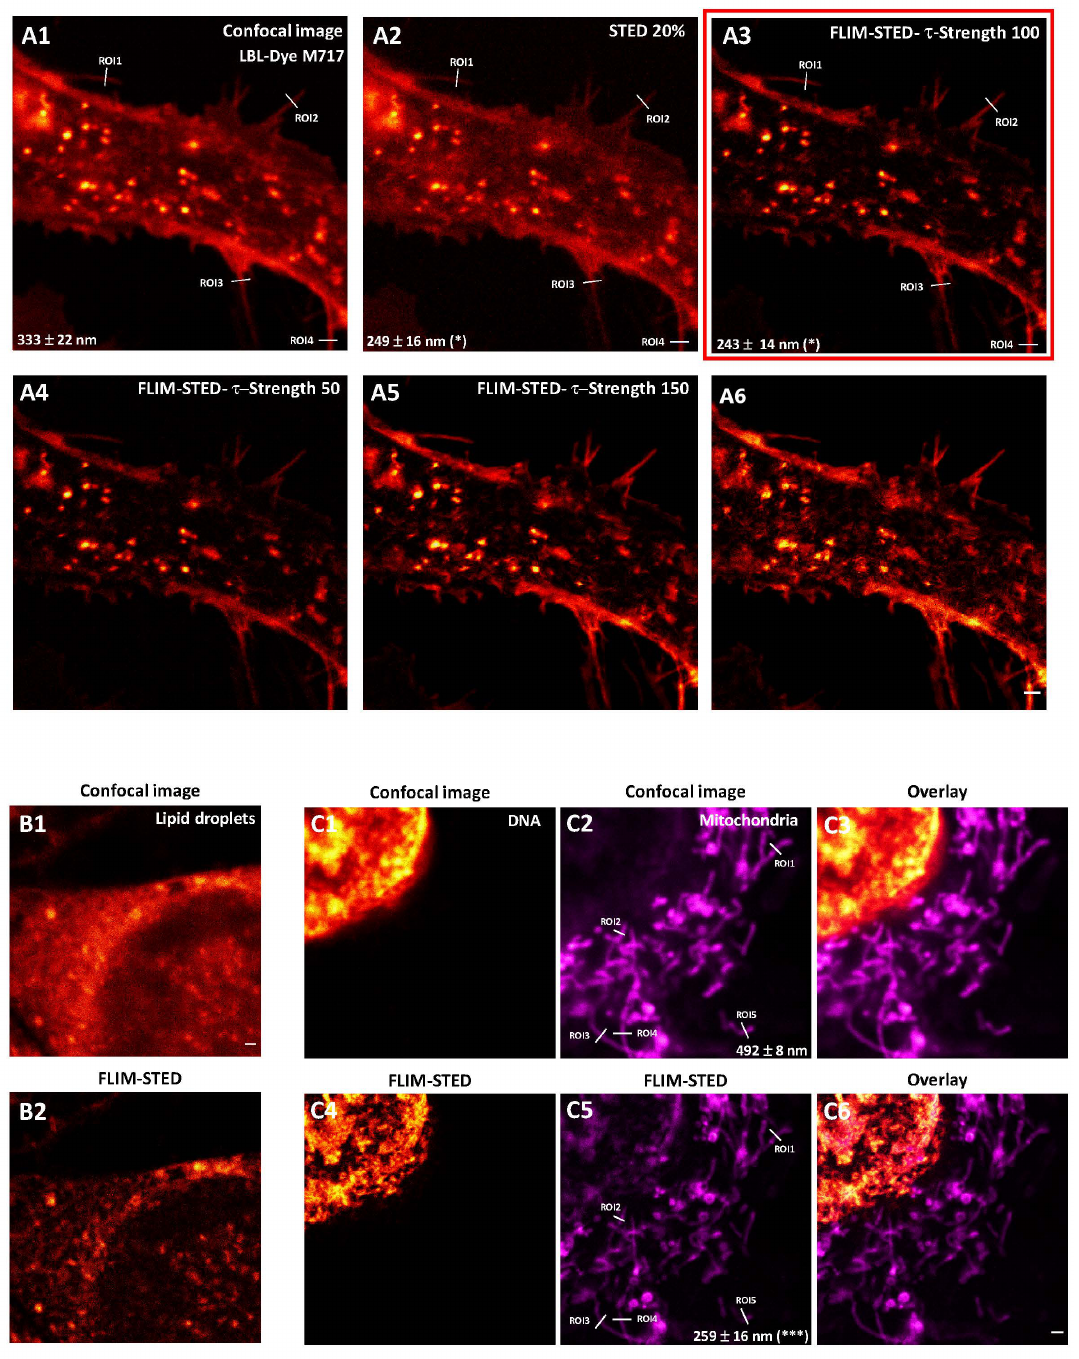
Figure 7. Input of FLIM in STED nanoscopy of living H28 cells labeled with red/near-infrared dyes. Confocal ( A1 ) and STED (20% 775-nm depletion laser, ( A2 )) imaging of LBL-Dye M717-labeled H28 cells (ex 690 nm, 3%, HyD-X). ( A3 – A6 ) Impact of τ Strength factors (50–200) on STED imaging. Red box indicates best parameters configuration. Significant lateral resolution differences between imaging approaches (* p < 0.05 vs confocal approach) were determined using an ANOVA test followed by a Tukey–Kramer multiple comparison test. Confocal ( B1 ) and FLIM-STED (100 τ Strength factor, ( B2 )) imaging of Nile Red-labeled H28 cells (ex 660 nm, 5%, HyD-X). Confocal ( C1 – C3 ) and FLIM-STED (100 τ Strength factor, ( C4 – C6 )) imaging of SPY620-DNA-(ex 618 nm, 15%, em 625–670 nm, HyD-X) and LBL-Dye M715 (690 nm, 20%, em 700–750 nm, HyD-R)-labeled H28 cells in simultaneous mode. Significant lateral resolution differences between imaging approaches (*** p < 0.001 vs confocal approach) were determined using Student’s t -test. Scale bars 1 µ